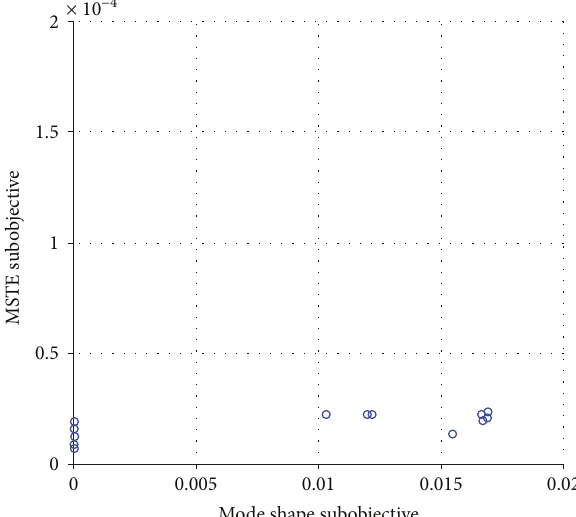
Figure 8: Optimal front obtained from MOLFPSO/TOPSIS in damage scenario 2.